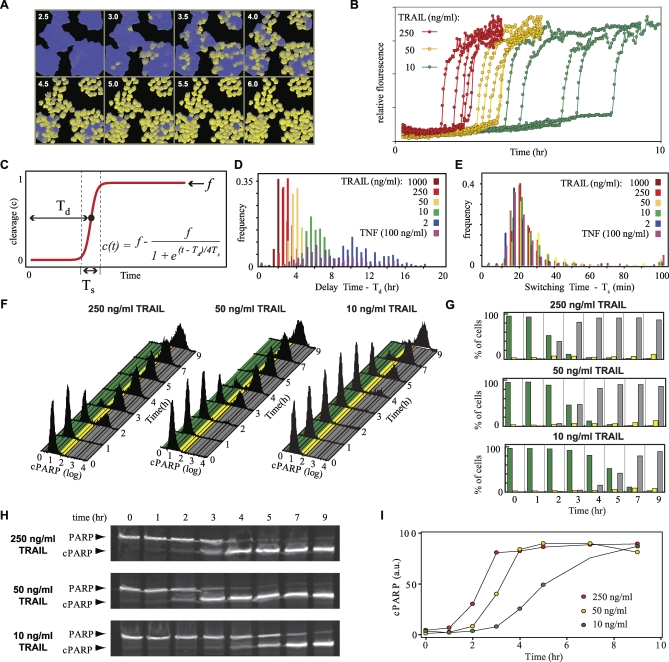
Dynamics of Caspase Activation in Cells Treated with TNF or TRAIL(A) Time-lapse images of HeLa cells expressing EC-RP treated with 50 ng/ml TRAIL. Imaging was performed at 465 nm and 535 nm; cleavage of EC-RP caused a shift in the 465/535 ratio that was pseudo-colored as a shift from blue to yellow. Inset numbers indicate the time in hours after treatment with TRAIL.(B) Time courses of EC-RP cleavage in individual HeLa cells treated with 250, 50, or 10 ng/ml TRAIL; five cells are shown for each dose. Cell-to-cell variation in dynamics for a single dose is observed reproducibly and is not a consequence of imprecision in the assay.(C) Idealized single-cell time course for EC-RP cleavage, showing relationships among Td (delay time), Ts (switch time), and f (fraction substrate cleaved).(D, E) Frequency distributions for Td (D) and Ts (E) determined by live-cell microscopy in EC-RP-expressing HeLa cells treated with varying concentrations of death ligand (n > 100 for each condition); binning intervals were 30 min (E), or 5 min (F).(F) Flow cytometry of PARP cleavage, as assayed with an antibody selective for PARP cleaved at Asp214 by C3 and C7, in HeLa cells treated with 10 to 250 ng/ml TRAIL for 1–9 h as indicated. Colored regions underlying the histogram represent intervals used to discretize data into PARP cleavage levels of <5% (green), 5%–25% (yellow), or >25% (gray; percentages are relative to the median fluorescence intensity of the fully positive population).(G) Discretized flow cytometry data. The fraction of cells having low, intermediate, or high PARP cleavage is color-coded to match the intervals in (F).(H) Immunoblot analysis of PARP cleavage in HeLa cells treated with 10 to 250 ng/ml TRAIL.(I) Quantitation of the cleaved 89 kDa form of PARP for blots shown in (H).